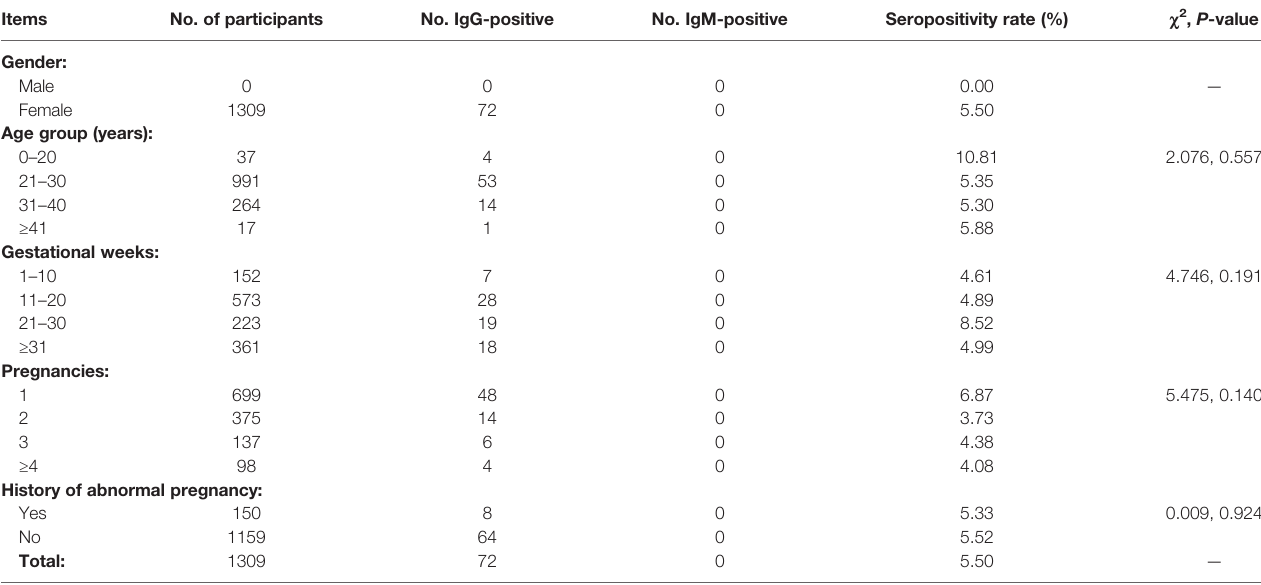
TABLE 3 | Seroprevalence of toxoplasmosis in pregnant